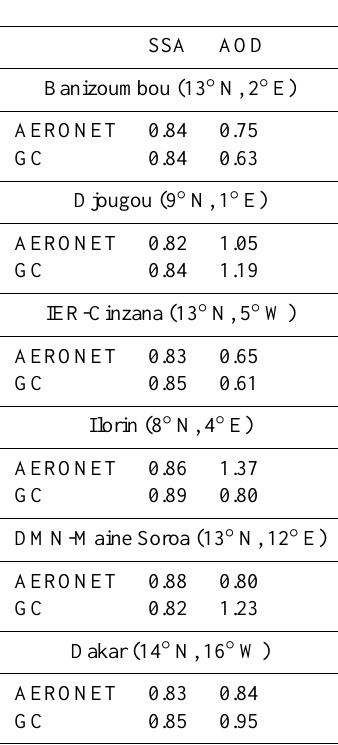
Table 3. Simulated and observed mean SSA and AOD columns at several AERONET sites during DABEX. SSA